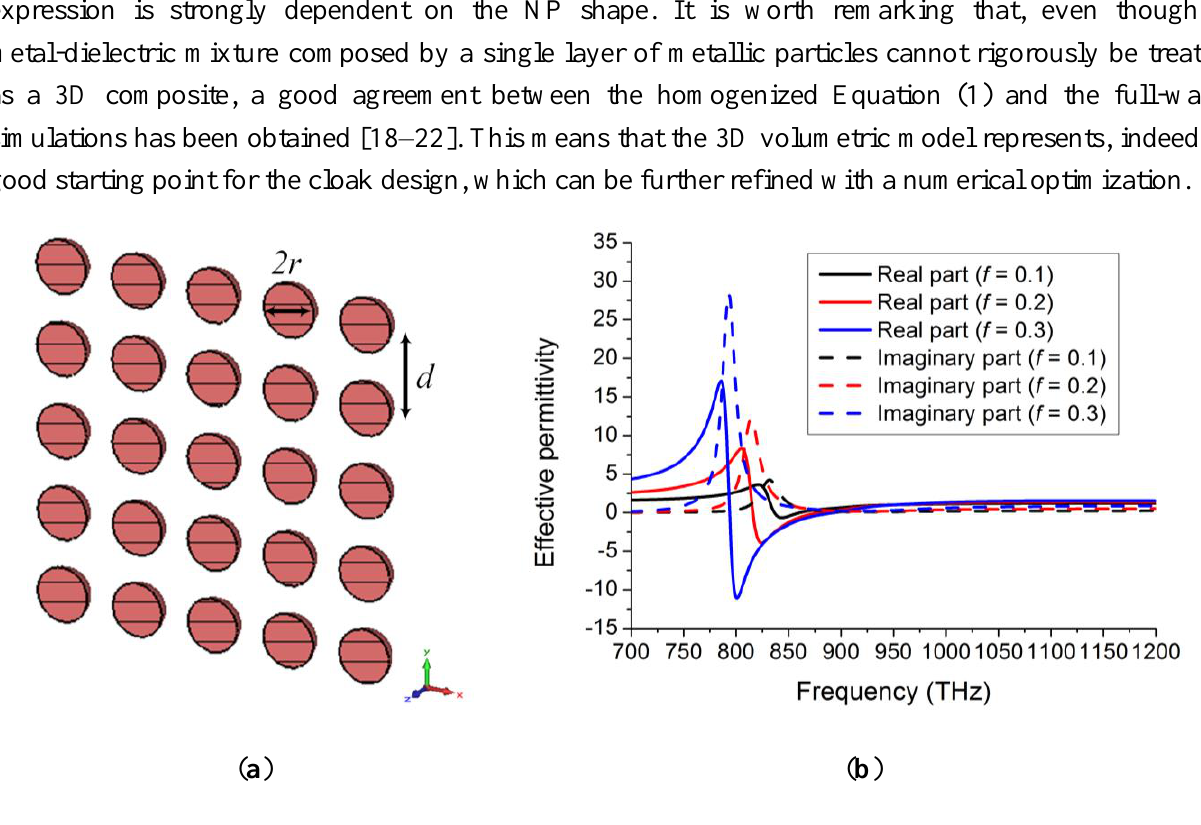
Figure 1. ( a ) Array of spherical plasmonic NPs. ( b ) Effective relative permittivity of different arrays of spherical silver NPs embedded in